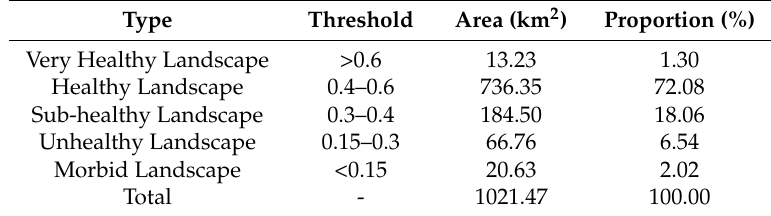
Figure 10. Spatial distribution of landscape ecological health. Table 2. Area and proportion of each level of landscape ecological